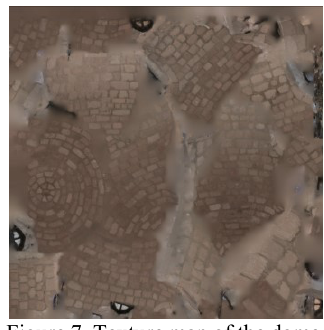
Figure 7. Texture map of the